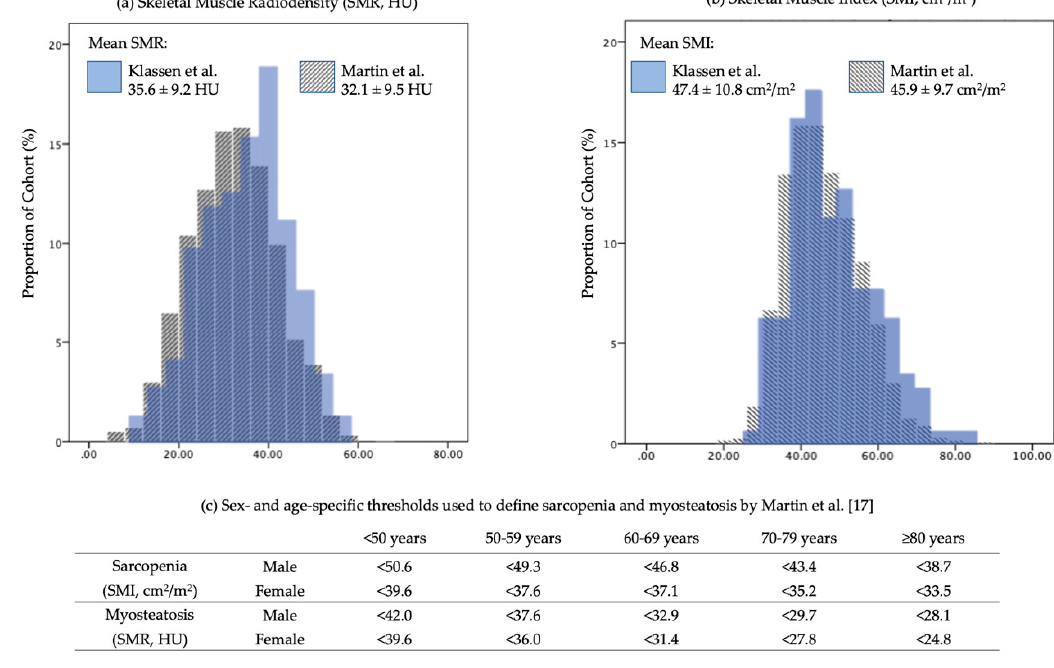
Figure 1. ( a ) and ( b ). Similar distributions of ( a ) skeletal muscle radiodensity and ( b ) skeletal muscle index from two pre-operative colorectal cancer cohorts: the present cohort ( N = 176) and Martin et al. ( N = 2100) [17]. ( c ). Martin et al. thresholds for sarcopenia and myosteatosis using skeletal muscle index (SMI) and skeletal muscle radiodensity (SMR), respectively, developed based on associations with longer post-operative length of stay in early-stage colorectal cancer patients [17].